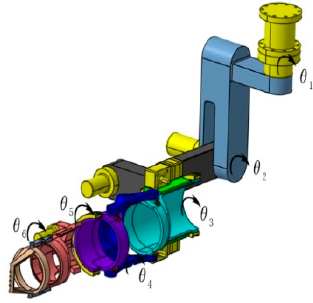
Figure 6. 3D rehabilitation robot.